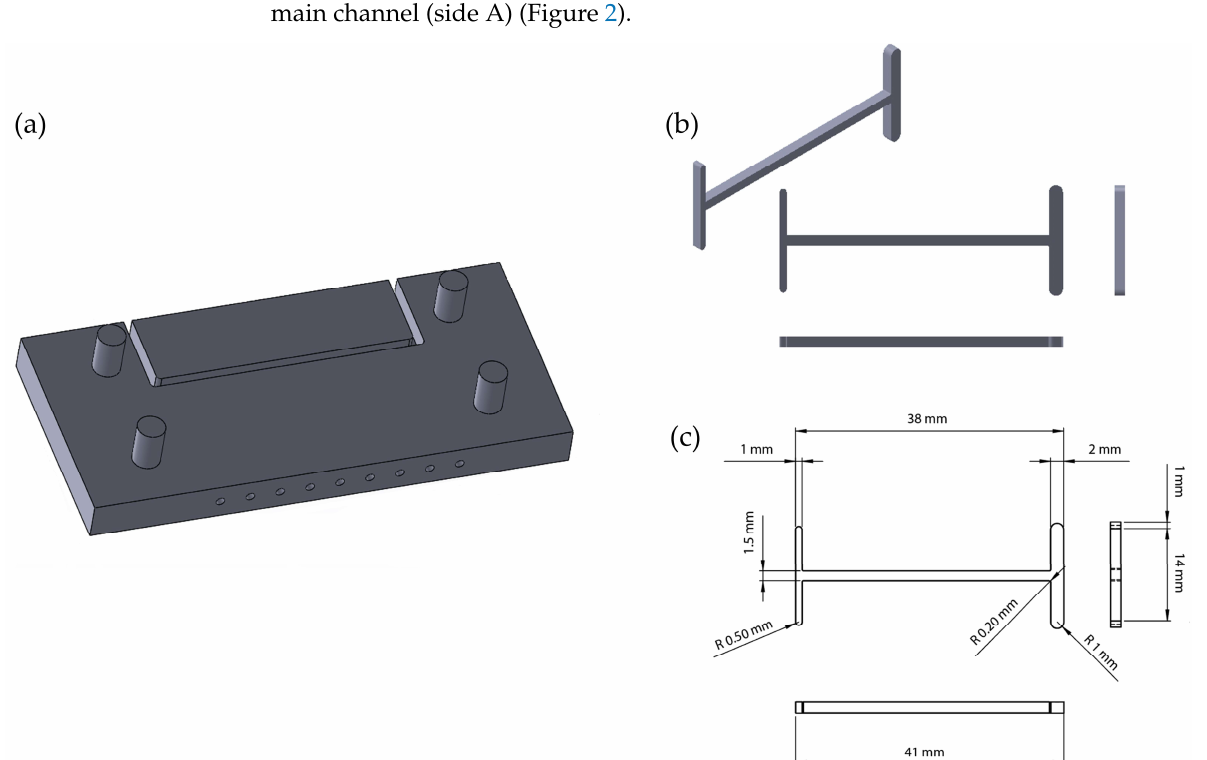
Figure 1. Graphical representation of the ( a ) Microfluidic device; ( b ) Microfluidic channel; ( c ) Overall microfluidic channel dimensions.